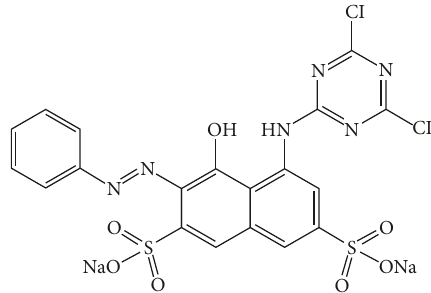
Figure 1: Chemical structure of RR-2 (chemical